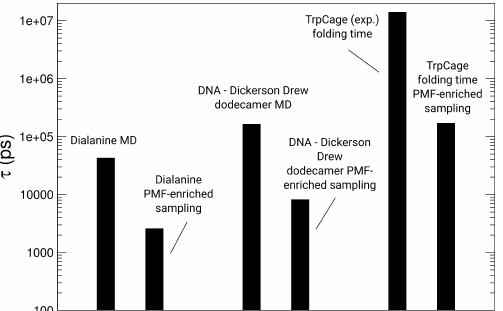
Figure 8. Comparison of timescales τ for relevant transitions of the systems simulated in this study with the PMF-enriched sampling technique: dialanine, the Dickerson–Drew DNA dodecamer, and TrpCage (experimental folding times ranging from 1.6 to 4 µ s [113,114,116]). In each of the cases, we observe a significant acceleration of the PMF-enriched sampling technique compared with standard MD and experiments. For dialanine, we determine an acceleration by a factor ranging from n = 13.1 to n = 16.5. For the Dickerson–Drew DNA dodecamer, we measure that the PMF-enriched sampling is faster by a factor n = 20.0, while for TrpCage, we determine a factor of approximately n = 82.3 in comparison with the experiment.